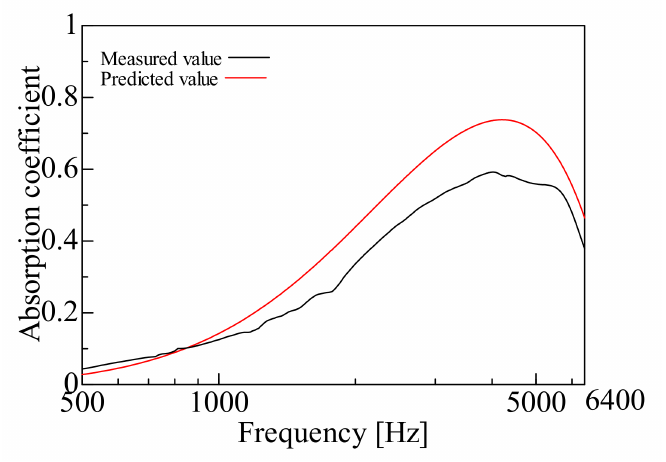
Figure 11. Comparison between the experiment and prediction (Sample C, m = 0.06 g/m 2 , t = 230 µ m, ρ = 348 kg/m 3 ).